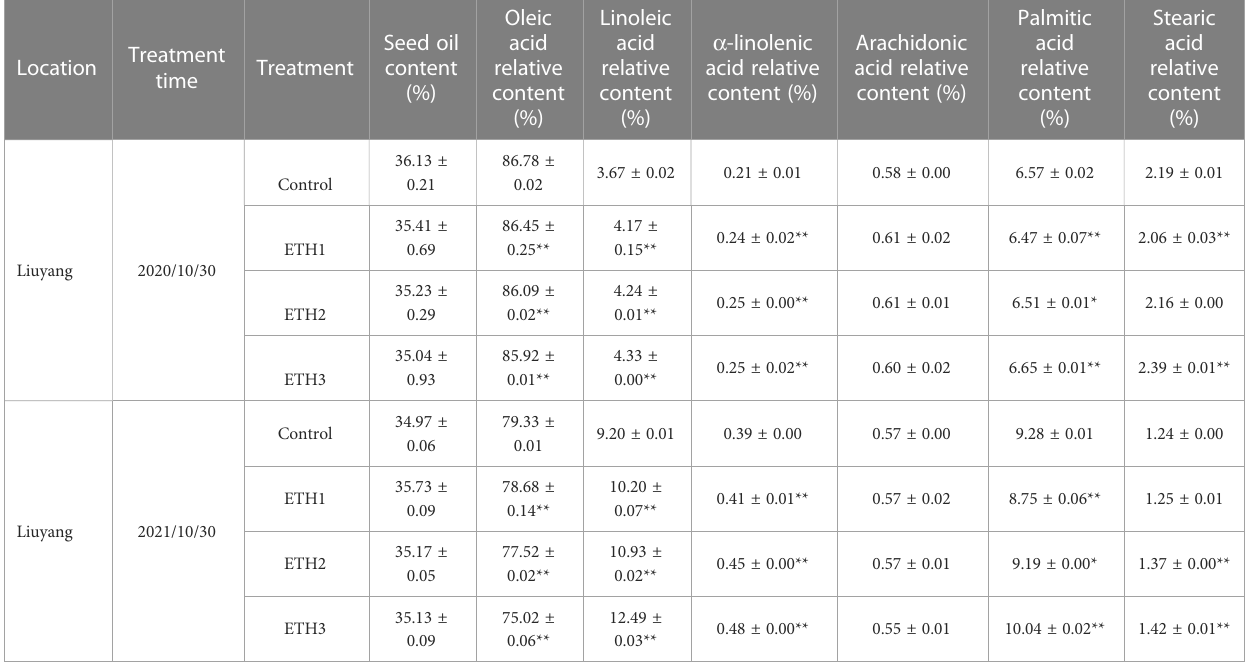
TABLE 2 Oil and relative fatty acid contents of three ethephon treatments and control in ‘ Huashuo ’ for two consecutive years.